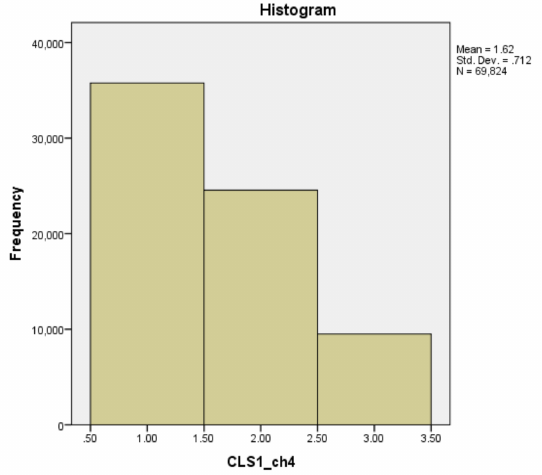
Figure 4. Histogram of clusters for the gas dataset with CH4.